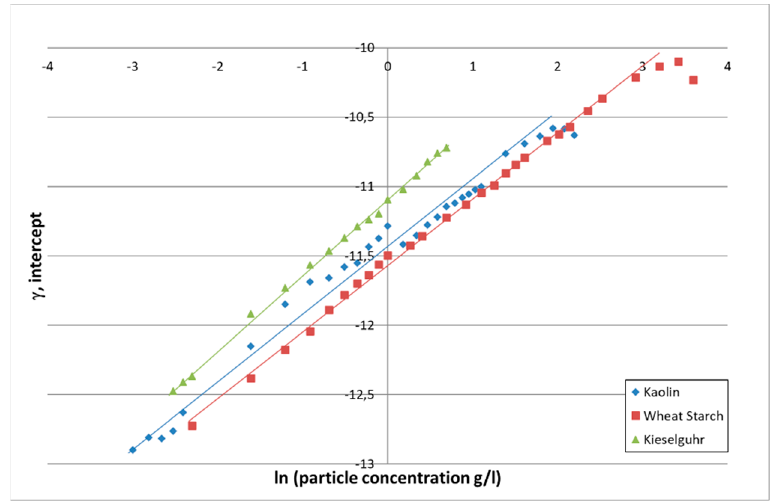
Figure 6. Evolution of the intercept value as a function of the logarithm of the particle concentration. Table 4. Linear regression analysis for intercept: γ = a i ln M + b i .